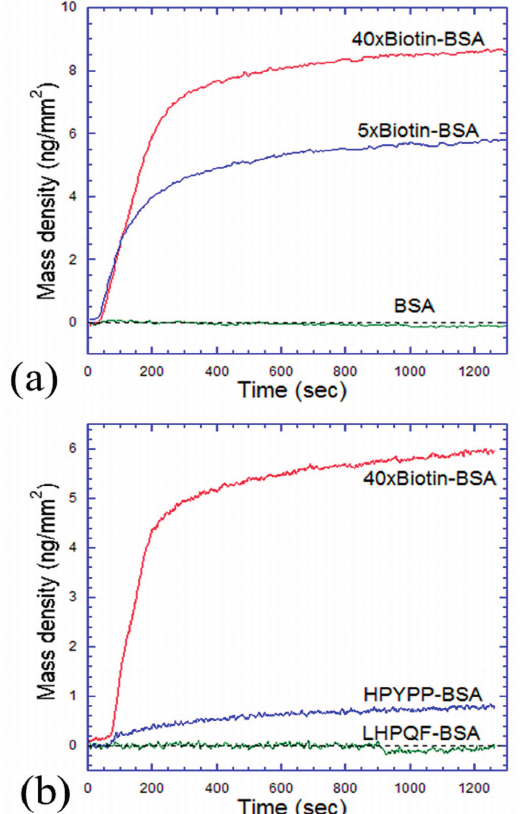
Figure 6. ( a ) OI-RD detection of streptavidin reacting with a line-shaped microarray containing BSA, 5× and 40× biotinylated BSA. 83 nM of streptavidin was added; ( b ) OI-RD detection of avidin reacting with a line-shaped microarray containing 40× biotinylated BSA, HPYPP and LHPQF conjugated BSA. 83 nM of avidin was added. All curves in (a) and (b) were compensated by subtracting the substrate